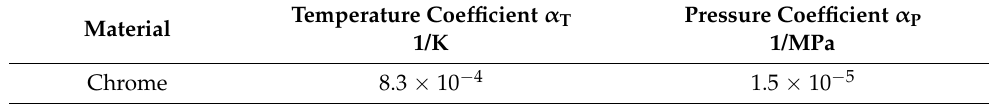
Table 4. Elastic-plastic properties of the surfaces.